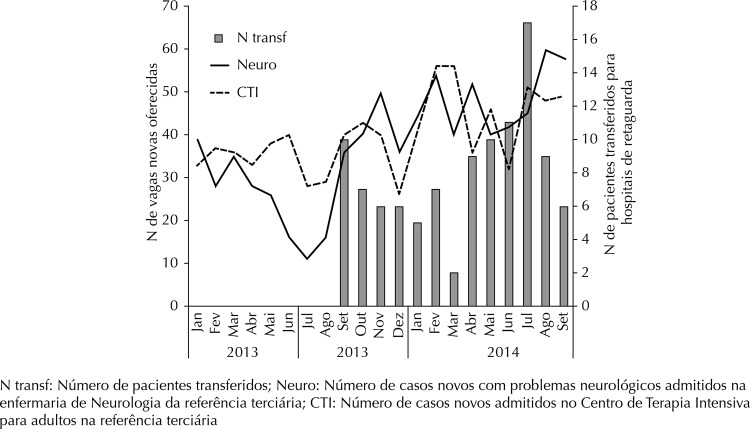
Número de vagas novas oferecidas para Terapia Intensiva e Neurologia (Linhas - Eixo Y à esquerda) pela instituição terciária de acordo com o número de pacientes transferidos para hospitais de longa permanência (Colunas - Eixo Y à direita) em função do tempo (Eixo X). A seta não preenchida aponta o início da Fase 1 do projeto e a seta preenchida aponta o início da Fase 2.